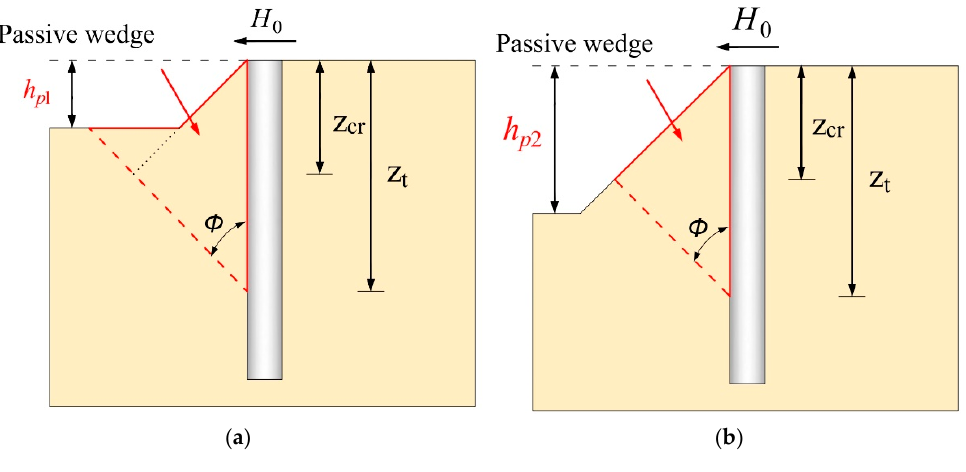
Figure 11. The theoretical largest passive wedge for ( a ) ℎ (cid:3043)(cid:2869) and ( b ) ℎ (cid:3043)(cid:2870) .